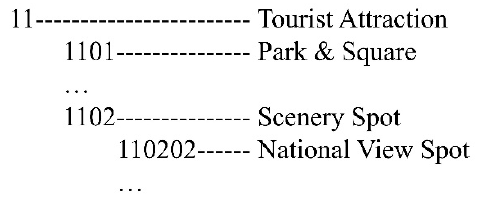
Figure 2. The three-level category system of Gaode POI.